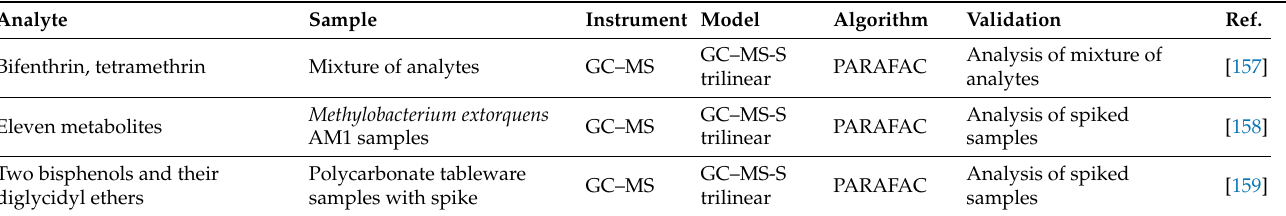
Table 5. Analytical applications of gas chromatography–mass spectrometry (GC–MS) assisted by three-way analysis based on the trilinear